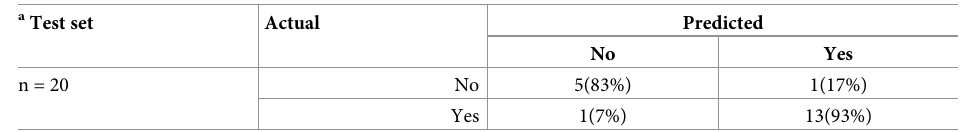
Table 3. Test set confusion